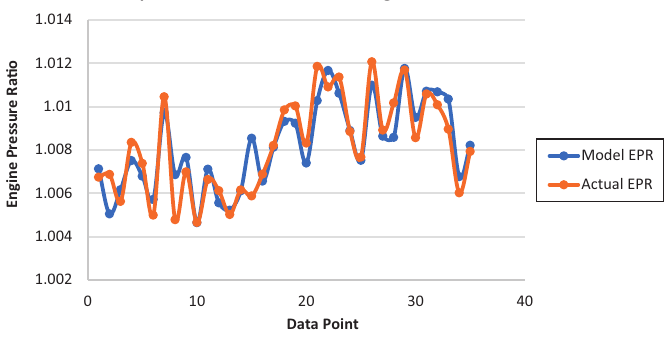
Figure 4. Comparison of model vs operational engine pressure ratios per data